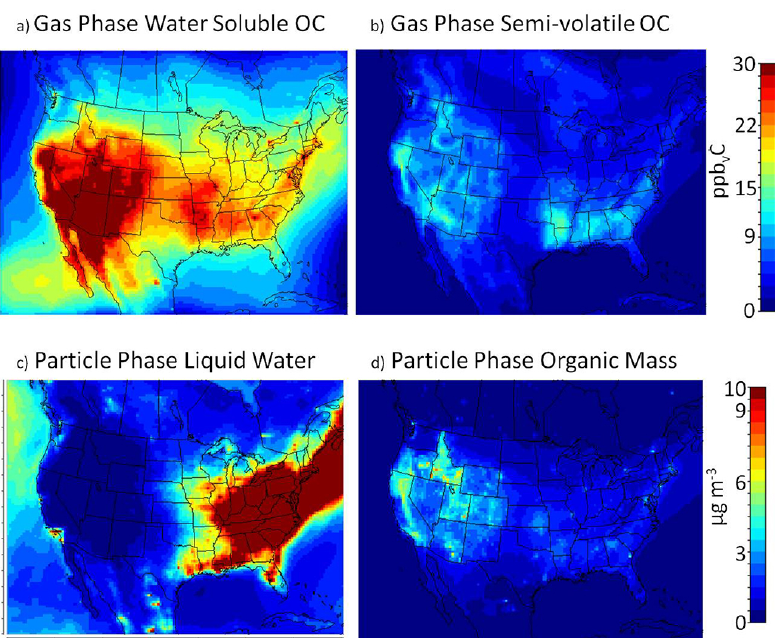
Fig. 7. Qualitative comparison of the potential of water-soluble gases to partition to aerosol water (left) versus the potential of semi-volatile gases to partition particle-phase organic matter (right). All values are averaged for July 2003. Included are species for which laboratory experiments have been conducted, as in Fig.